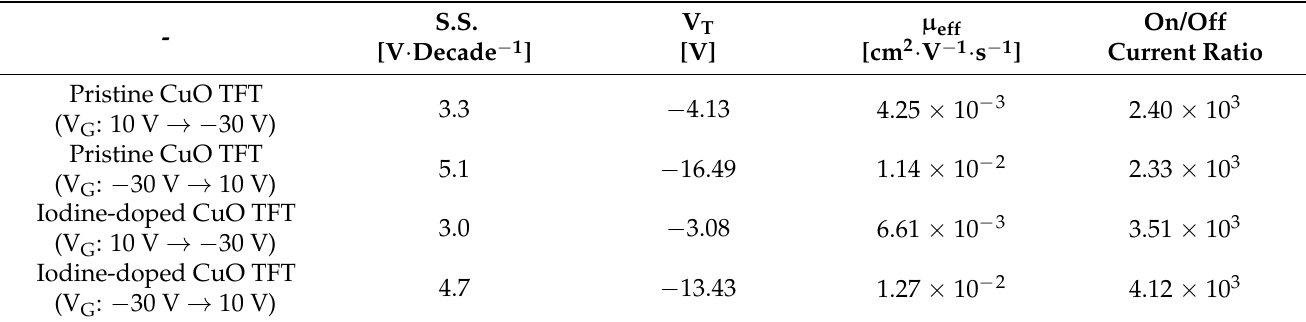
Table 1. Summary of performance parameters for the pristine and iodine-doped CuO TFTs obtained by reversing the direction of V G sweep.